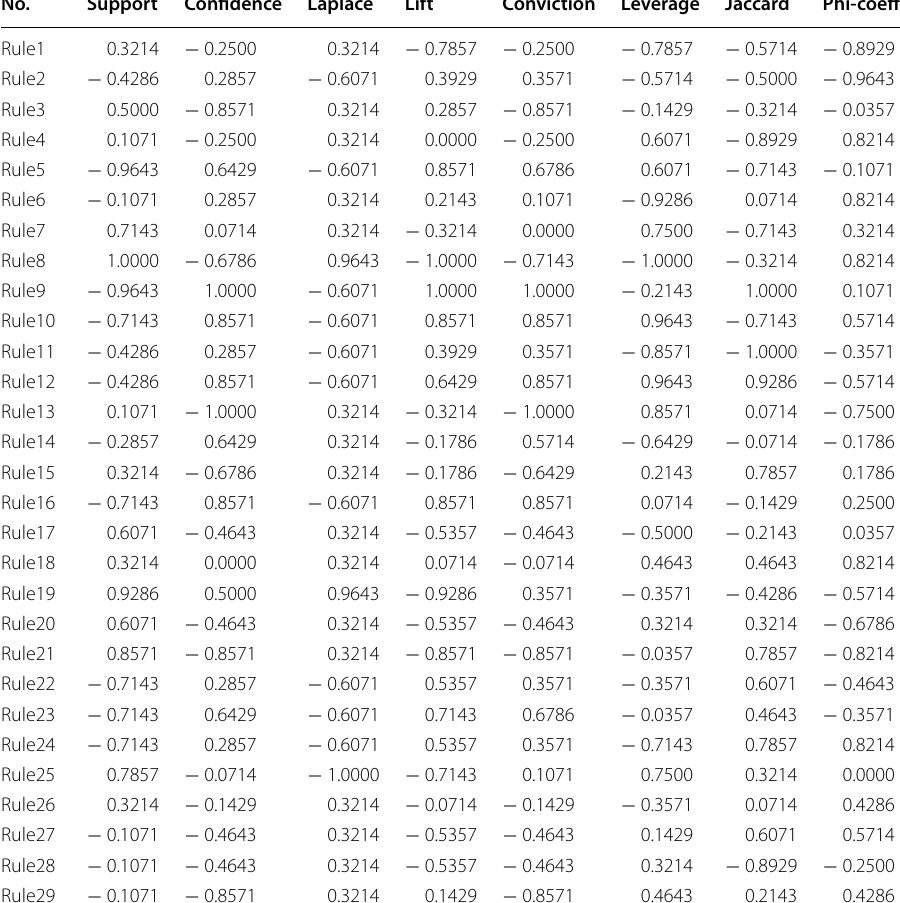
Table 9 Preference